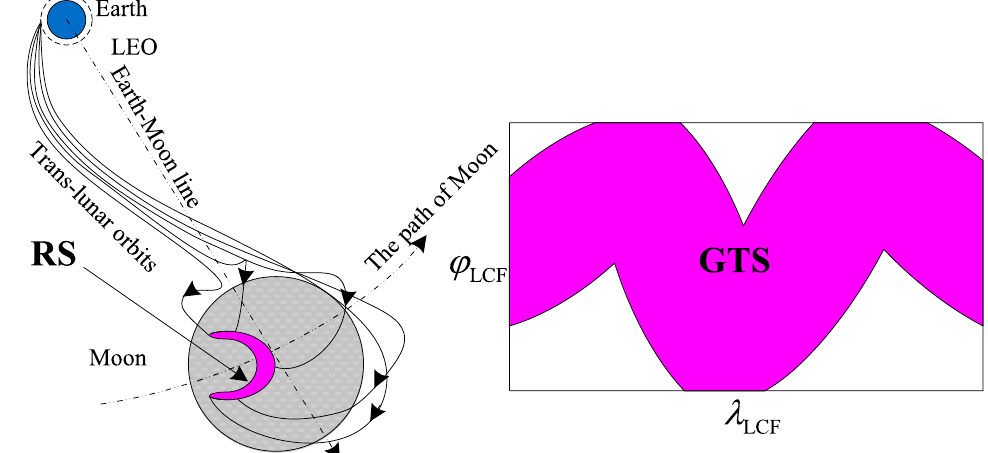
Fig. 2 Illustration of the reachable set and the GTS of the trans‑lunar